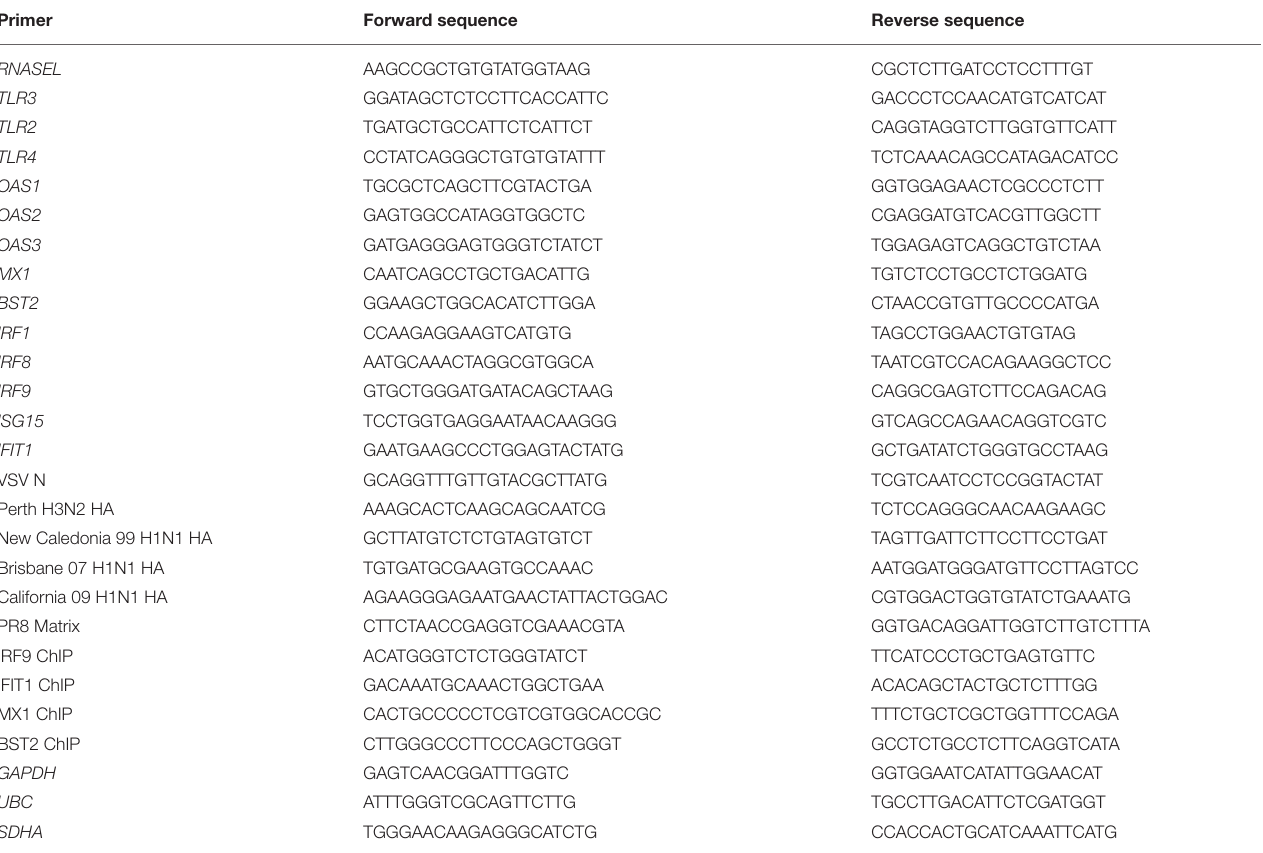
TABLE 1 | List of primers used in this study.